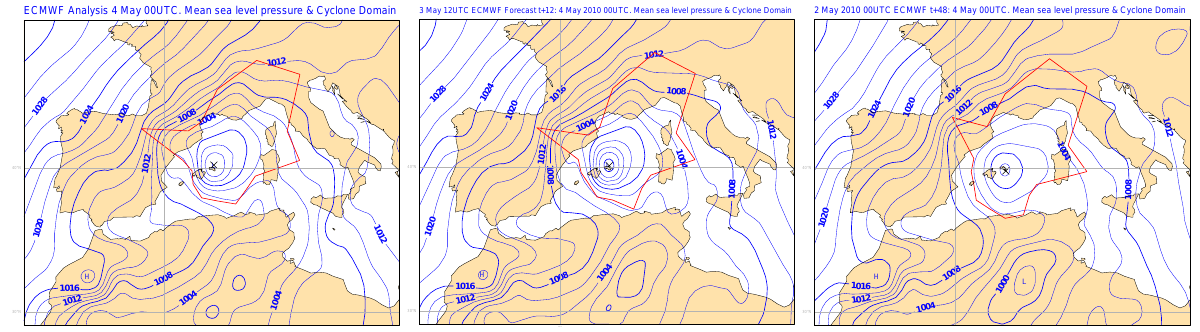
Fig. 6. Mean sea level pressure and Cyclone Domain (red), 4 May 201000:00UTC. ECMWF Analysis (left), Forecasts H+12 (centre), and H+48 (right).